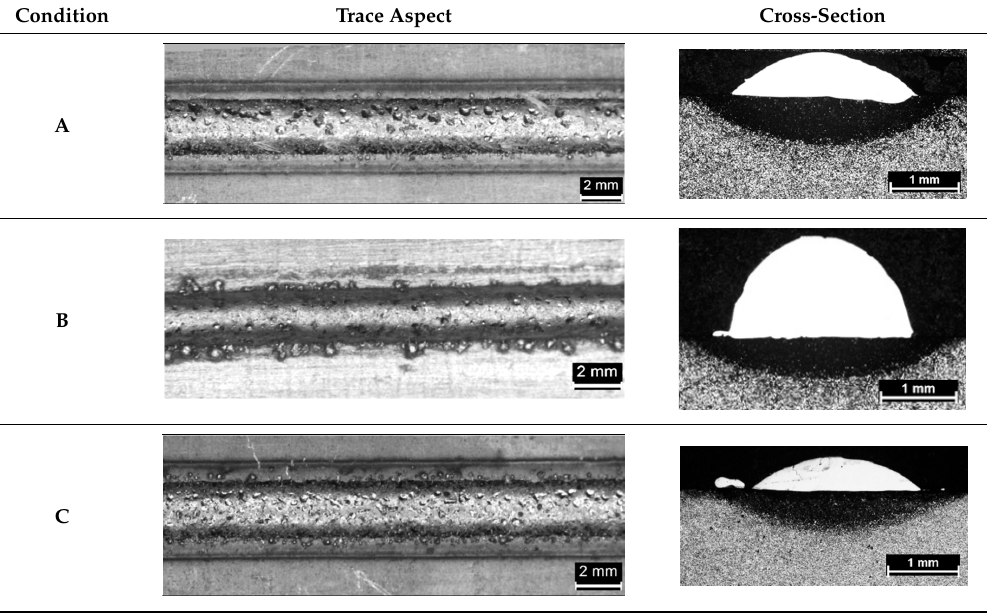
Table 4. Trace surface aspect and corresponding cross-section for deposition over a flat surface. Condition